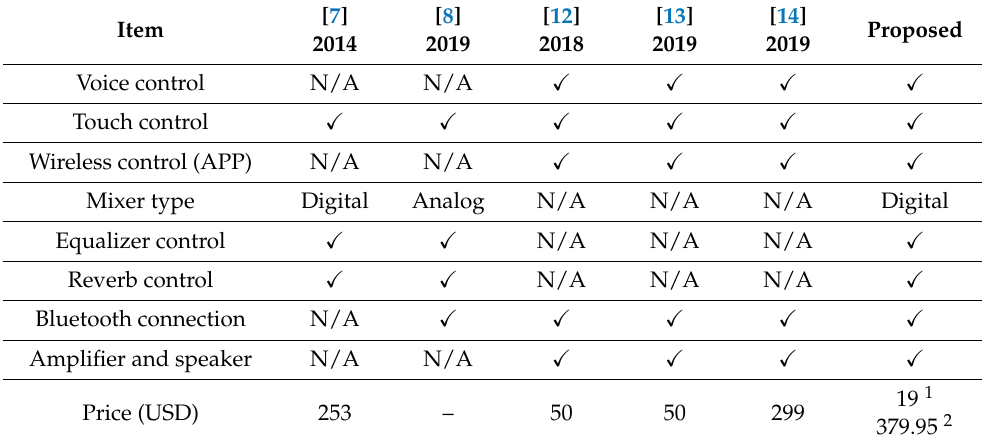
Table 3. A comparison between commercial smart speakers, mixers, and the proposed design.